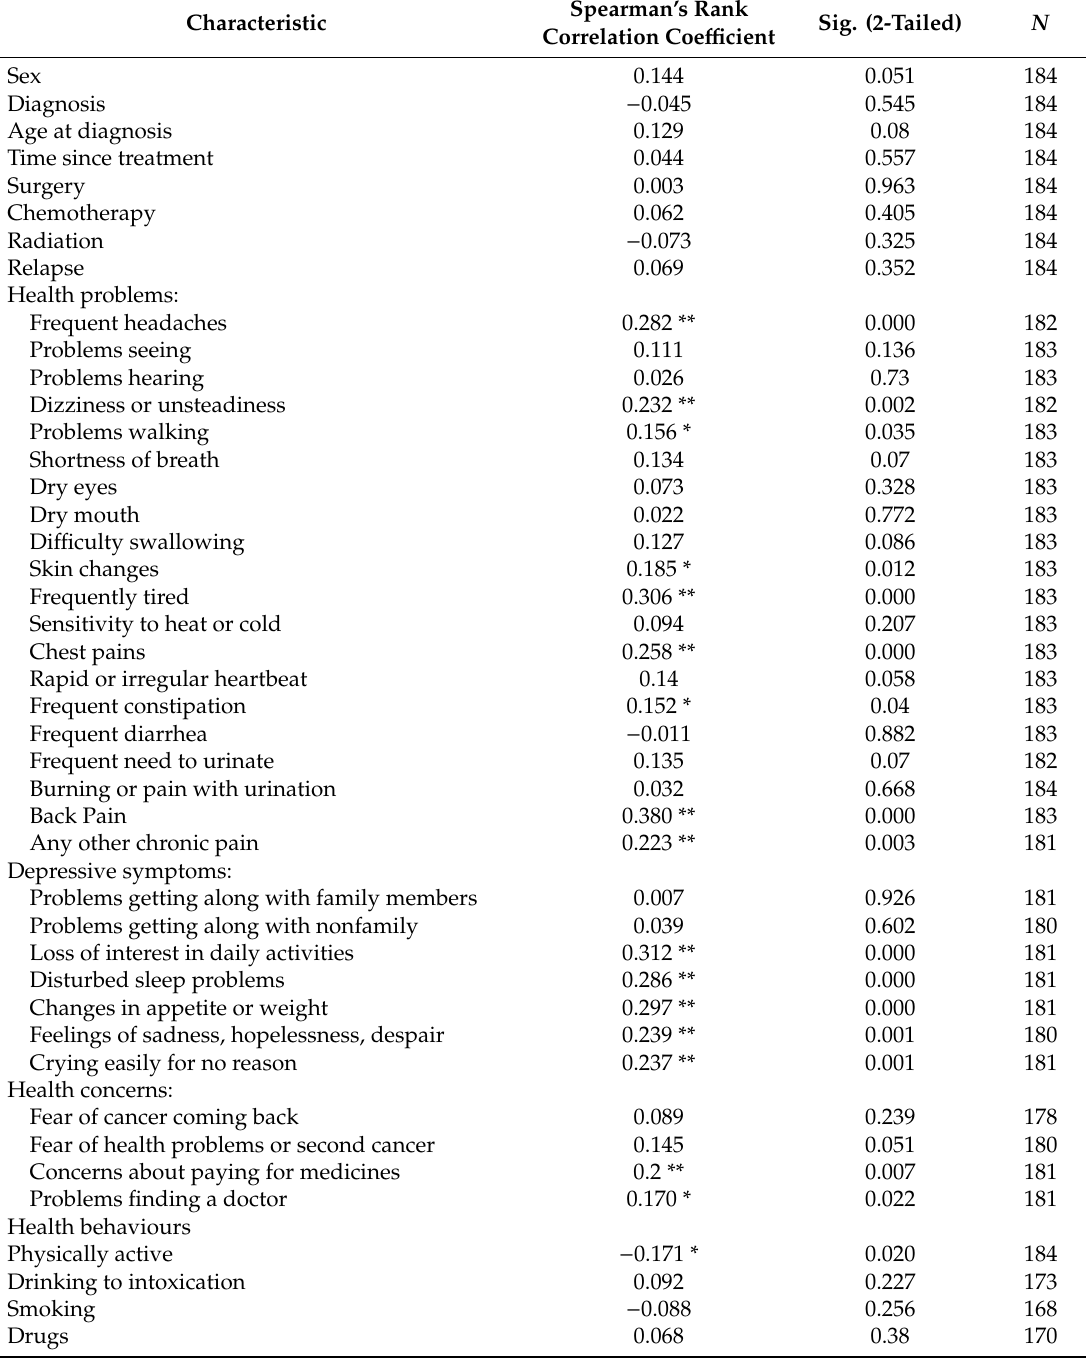
Table 4. Correlation matrix comparing perceived health with clinical variables, health problems and health behaviors of long-term childhood cancer survivors. Spearman’s Rank Sig. Characteristic Correlation Coe ffi cient